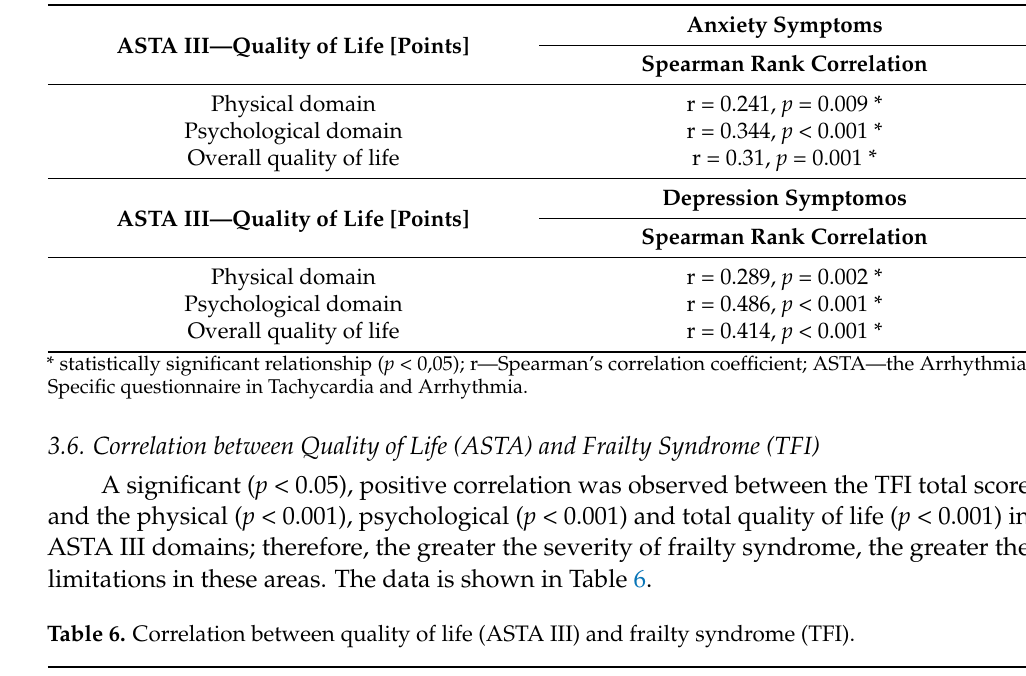
Table 6. Correlation between quality of life (ASTA III) and frailty syndrome (TFI). ASTA III—Quality of Life [Points] Physical domain r = 0.336, p < 0.001 * Psychological domain Overall quality of